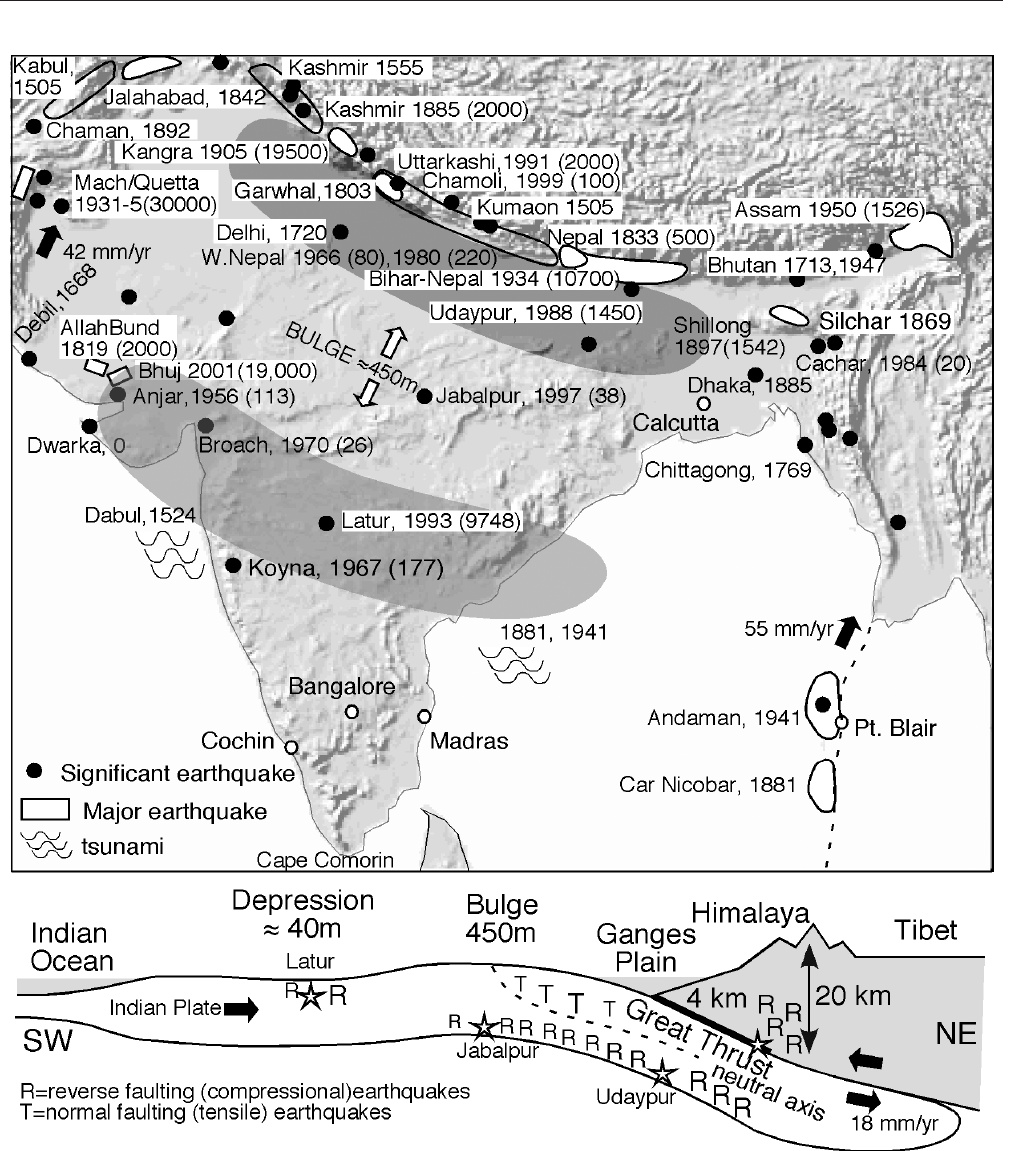
Fig. 1. Schematic views of Indian tectonics. Plate boundary velocities are indicated in mm/yr. Shading indi- cates flexure of India: a 4 km deep trough near the Himalaya and an inferred minor (40 m) trough in south cen- tral India are separated by a bulge that rises approximately 450 m. Tibet is not a tectonic plate: it extends east- west and converges north-south at approximately 12 mm/yr. At the crest of the flexural bulge the surface of the Indian plate is in tension and its base is in compression. Locations and dates of important earthquakes mentioned in the text are shown, with numbers of fatalities in parenthesis where known. With the exception of the Car Nico- bar 1881, Assam 1897 and Bhuj 2001 events, none of the rupture zones of major earthquakes are known with any certainty. The estimated rupture zones of pre-1800 great earthquakes are shown as unfilled outlines, where- as more recent events are filled